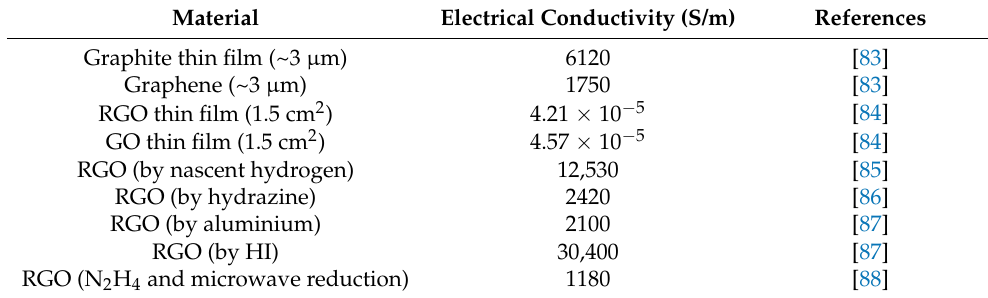
Table 1. An overview of the electrical conductivity of different graphene-based films/morphologies.